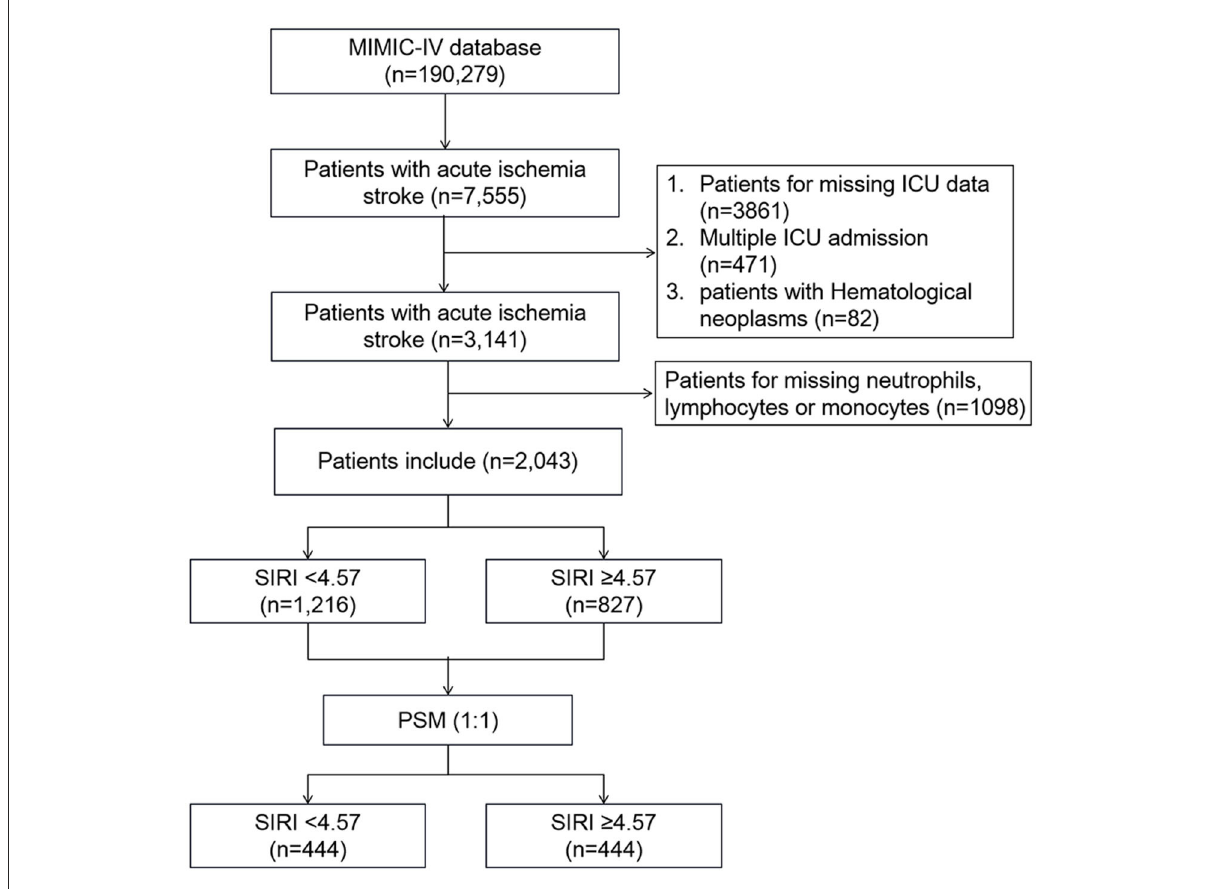
FIGURE1 Workflow chart for the patient selection process.